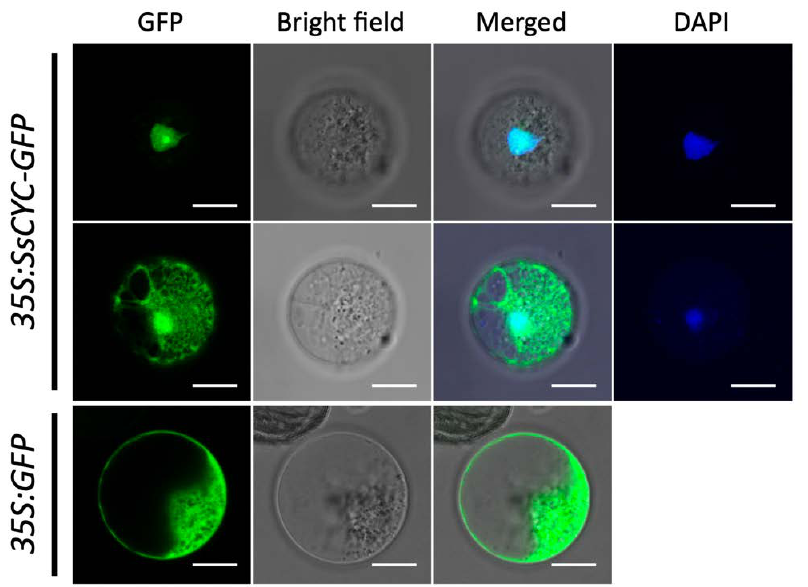
Figure 6. Subcellular localization of the SsCYC-GFP fusion protein in petal protoplasts of S. speciosa ‘ES’. The fluorescence emissions from GFP and DAPI are indicated by green and blue, respectively. Scale bars = 10 μm.